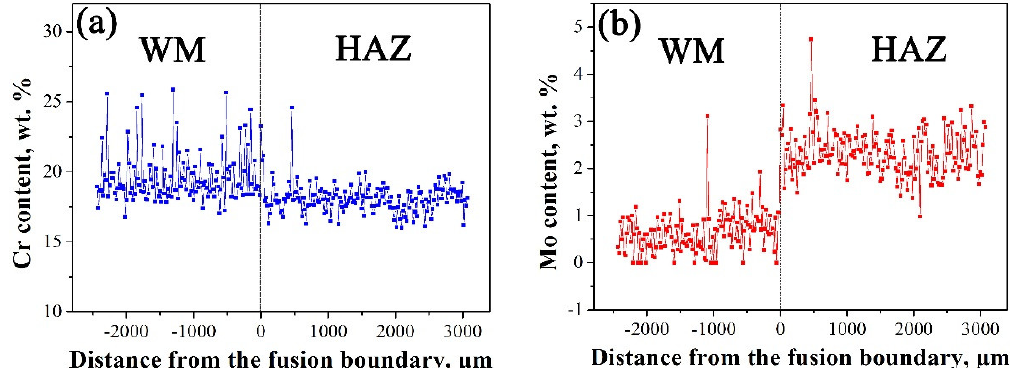
Figure 5. EDS line scanning curves across 308L-316L interface: ( a ) Cr and ( b ) Mo.